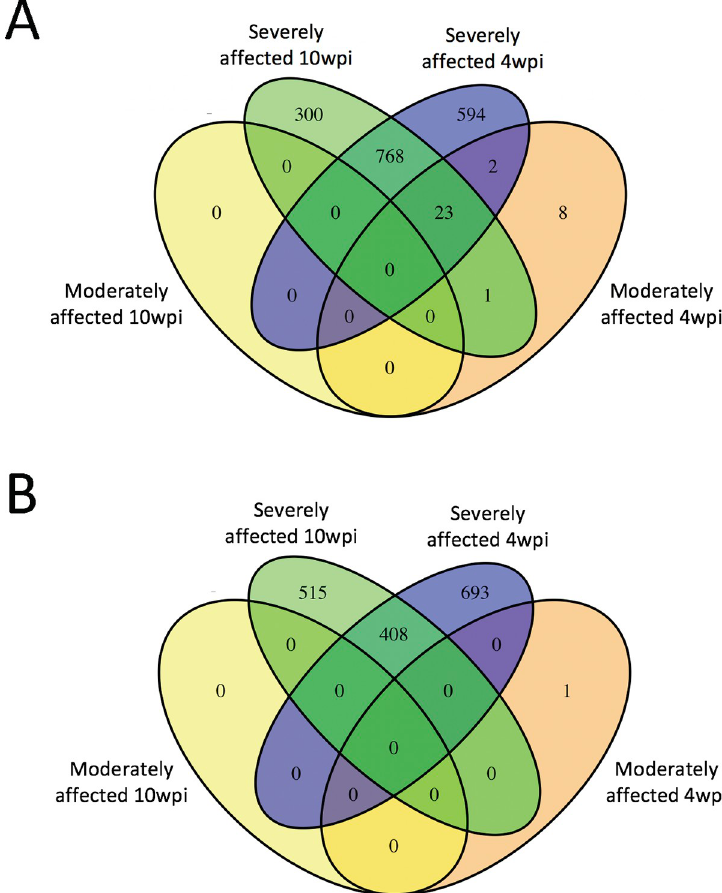
Fig 5. Common differential gene expression in infected clusters at 4 wpi. Venn diagram of differentially expressed genes with increased (A) and decreased (B) expression between moderately or severely affected cattle compared to uninfected cattle at 4 wpi and 10 wpi. Uninfected cattle n = 5, moderately affected cattle n = 3, severely affected cattle n = 4. wpi = weeks post-infection.